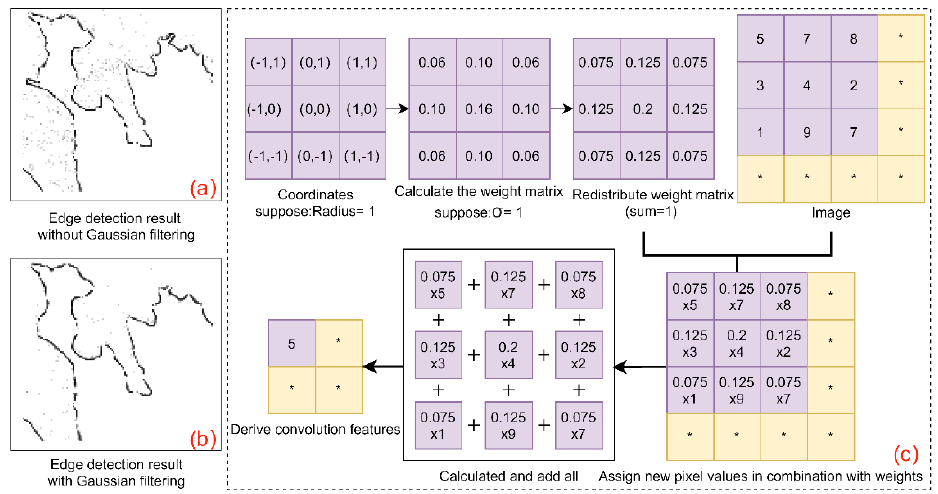
Figure 2. The principle and effect of Gaussian kernel convolution. ( a ) edge detection result without Gaussian filtering; ( b ) edge detection result with Gaussian filtering; and ( c ) Gaussian kernel convolution process.